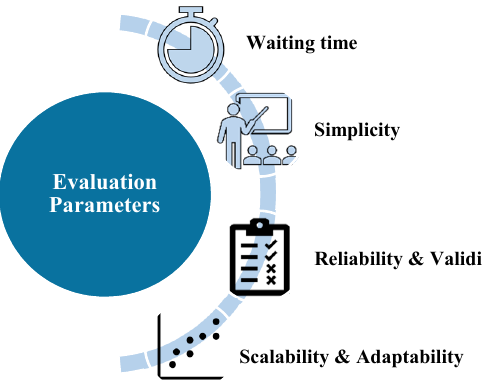
Figure 10. Triage system evaluation parameters.